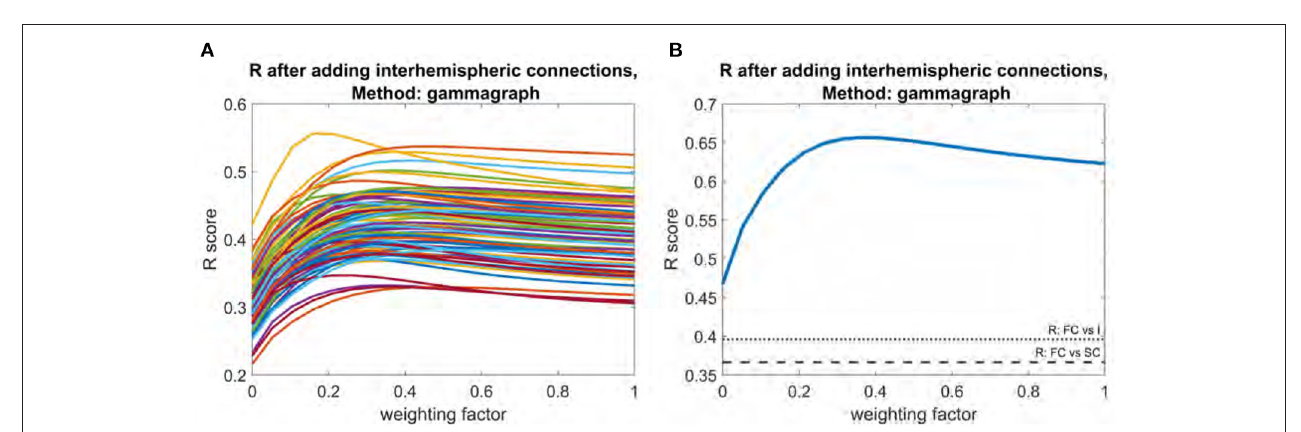
FIGURE 5 | Plot of R vs. weighting factor as interhemispheric matrix is added to SC. (A) R vs. weighting factor for all subjects, with each line representing an individual subject. (B) Model performance for the mean functional connectome. Dotted line indicates raw correlation between functional connectome and interhemispheric matrix. Dashed line indicates correlation between functional connectome and structural connectome.